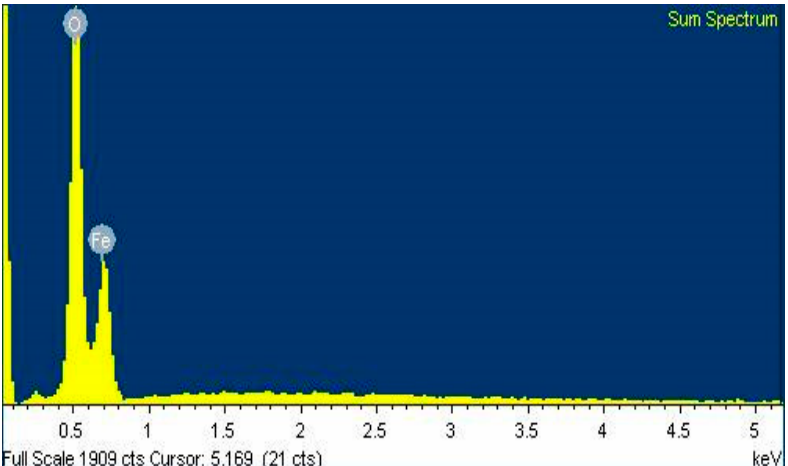
Figure 6. Energy dispersive X-ray spectroscopy (EDX) analysis spectra for Fe 3 O 4 nanoparticles .